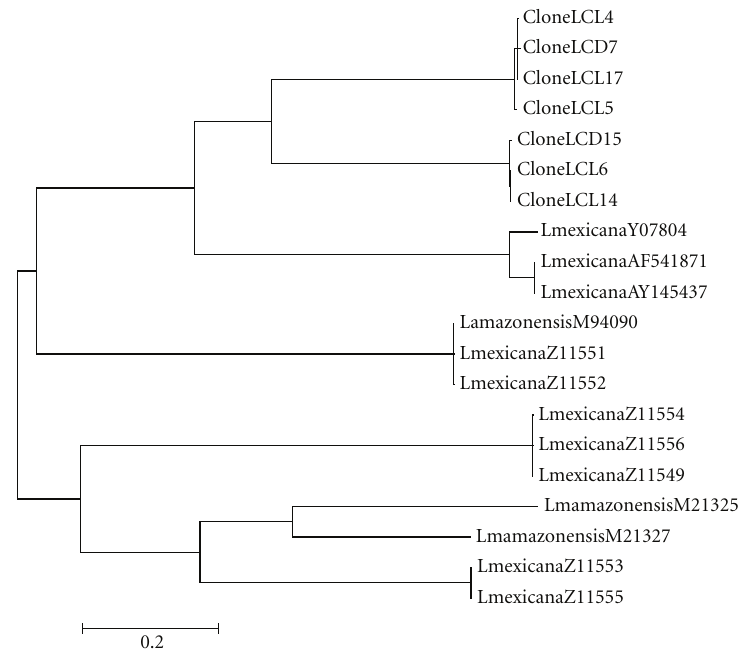
Figure 6: Phylogenetic tree constructed with sequences of kDNA minicircles. Leishmania mexicana complex members published in theGenBank: L. (L.) mexicana Y07807, AF54187, Y145437; L. (L.) amazonensis M 94090; L. (L.) mexicana Z11551, Z11552, Z11554, Z11556, and Z11549; L. (L.) amazonensis M21325, M 21327; L. (L.) mexicana Z11553, Z11555; clones of L. (L.) mexicana. Mexican isolates clones: LCL4, DCL7, LCL17, LCL5, DCL15, LCL6, and